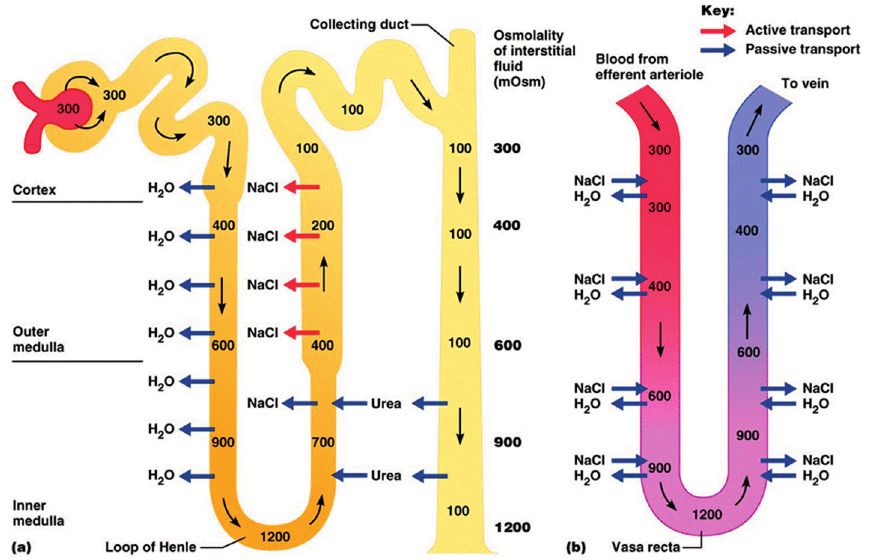
Figure 1. The Loop of Henle from the human kidney [25].